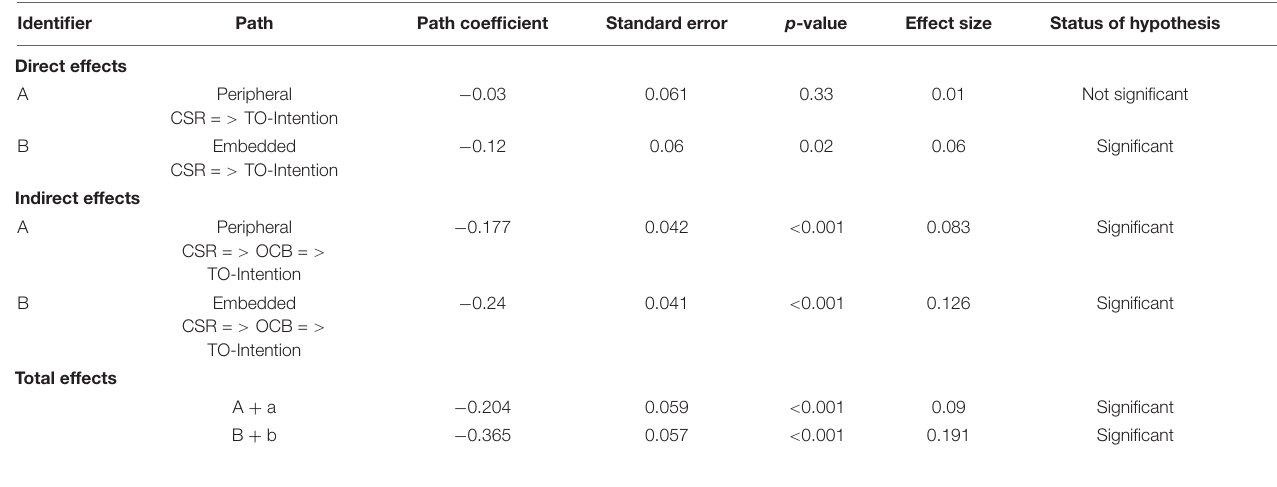
TABLE 5 | Summary of direct, indirect, and total